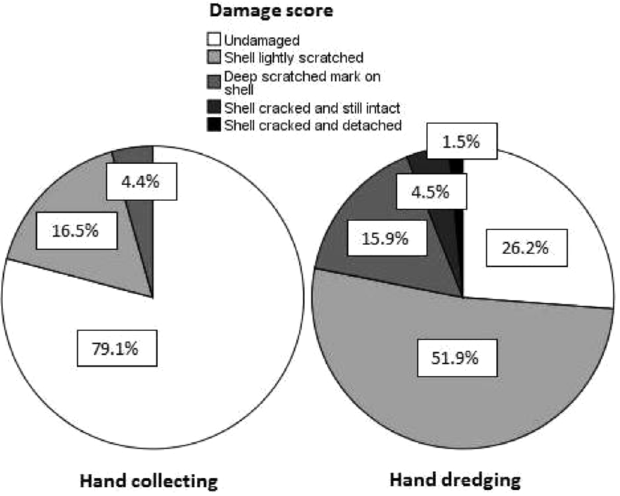
Fig. 6. Shell damage frequency and degree in fl icted to the hard clams caught by hand collecting ( n =109) and hand dredging ( n =